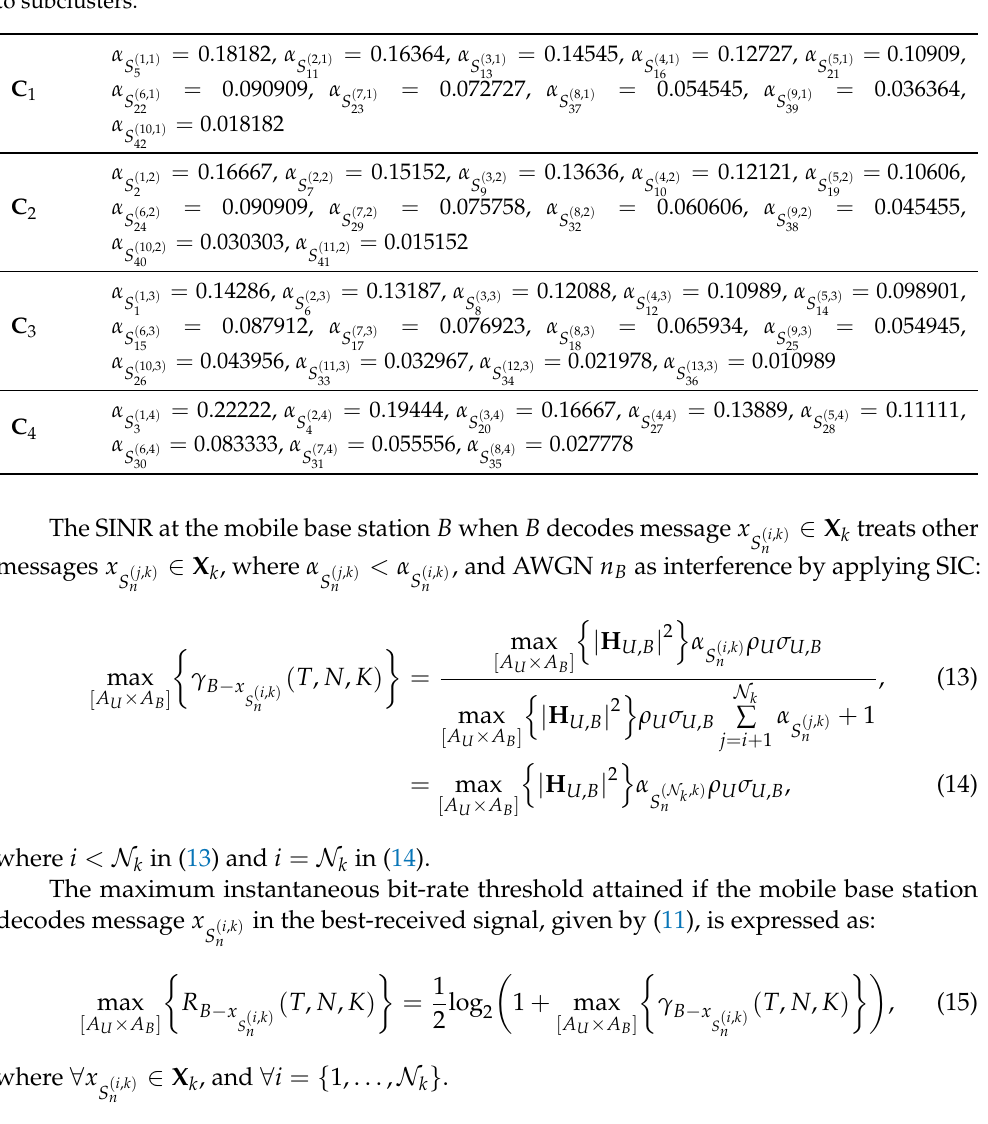
Table 6. Power allocation factors at wireless sensors for transmitting messages, arranged according to